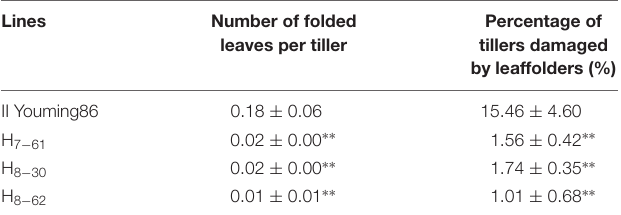
TABLE 2 | Resistance performance of transgenic hybrids in the field after natural infestation in 2013. Values are the means ± SD ( n = 3). Lines Number of folded Percentage of leaves per tiller tillers damaged by leaffolders (%)